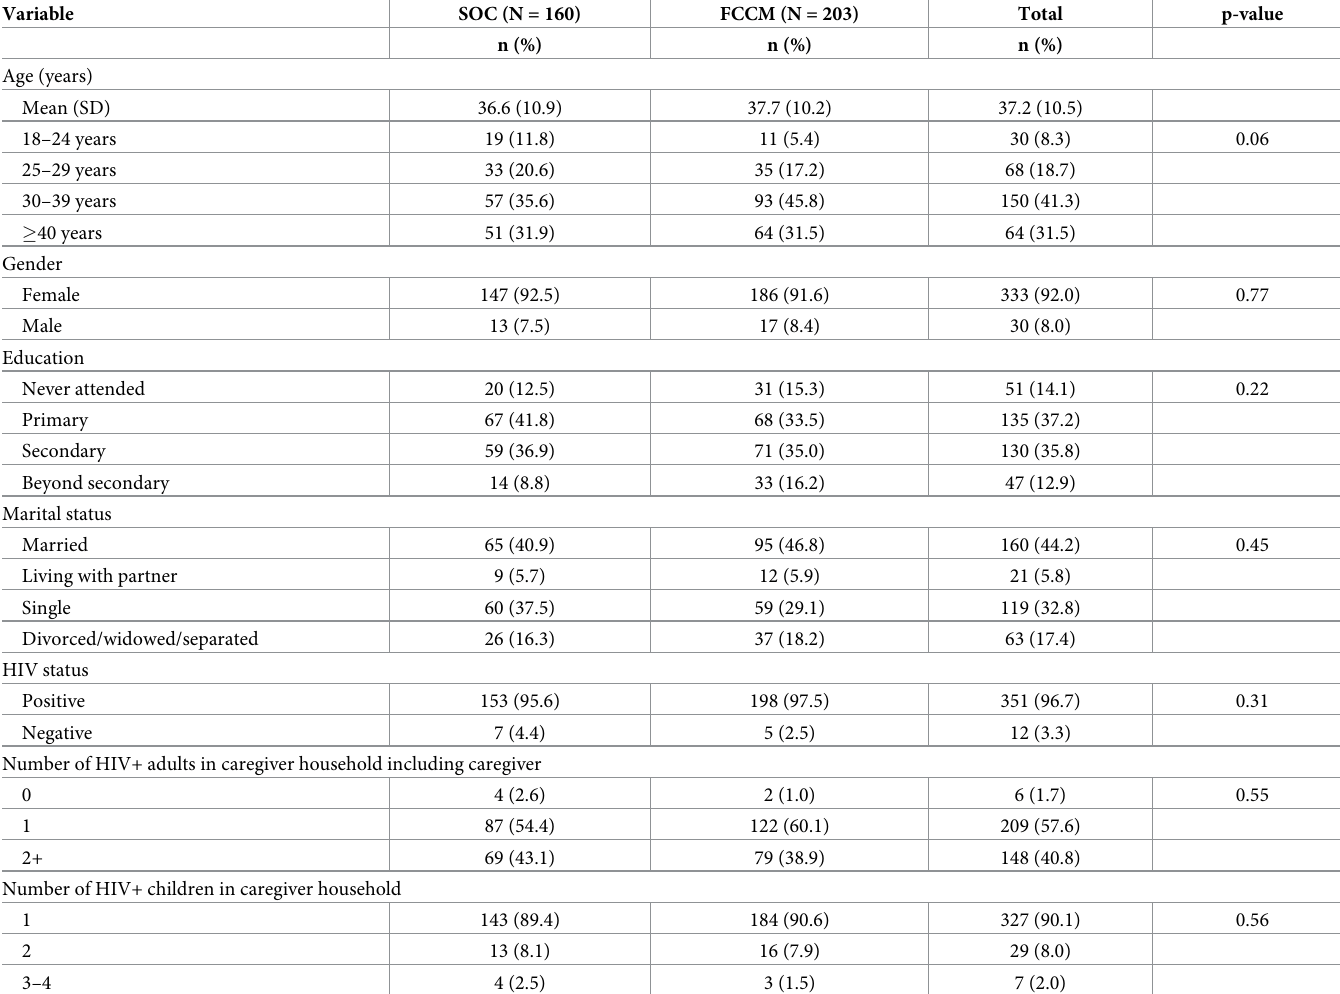
Table 2. Demographic characteristics, HIV and treatment history of